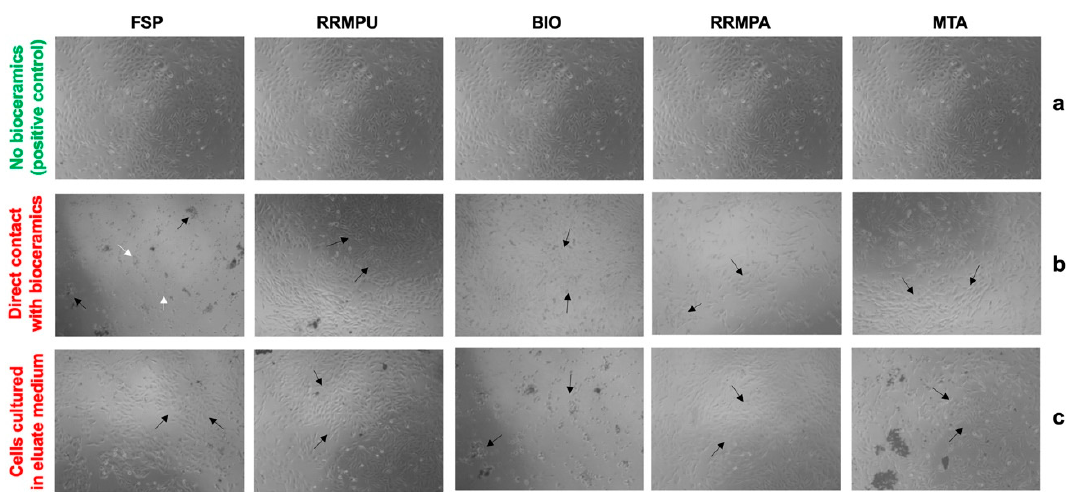
Figure 1. Cellular attachment and biocompatibility. To evaluate cell attachment and biocompatibility, MG-63 cells were observed with an EVOS inverted microscope for morphological alteration and adhesion evaluation. If cells appeared flat or partially-round and attached to the surface, the material was considered biocompatible. If cells were totally round and detached from the surface, the material was considered toxic and not biocompatible. ( a ) MG-63 cells cultured without any bioceramic material were used as positive control. ( b ) MG-63 cells were not a ff ected by direct contact with bioceramics. In the fast set putty (FSP) sample, cells acquired a round shape (white arrows) and detached from the disc surface. The cells remained in suspension after 24 h of treatment. After 48 h, the cells had re-attached to the surface. ( c ) MG-63 cells cultured in 1 mL of eluate medium (EM) were attached to the disc surface and no morphological di ff erences in the attachment or the growing of cells were identified. In ( b , c ), adherent cells are highlighted by black arrows.